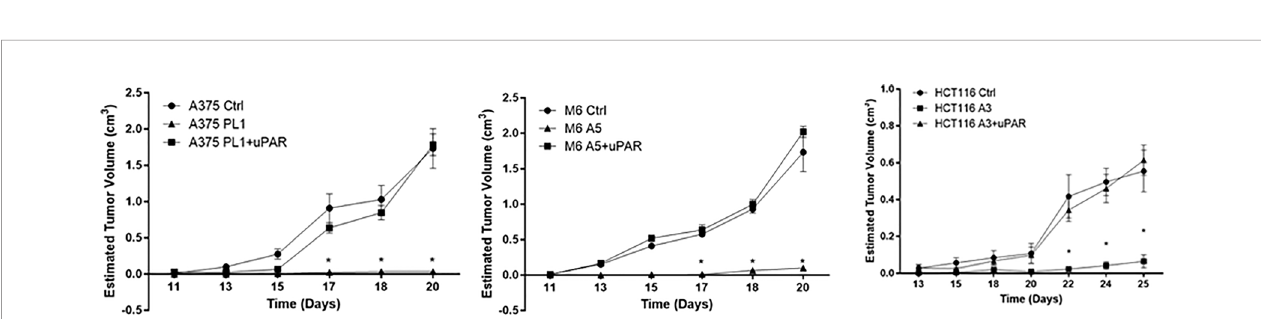
FIGURE 2 | Tumor growth curves of A375 (left), M6 (center) and HCT116 (right); from tumors appearance, masses were measured every two days with a caliper. Each point represents the mean tumor volume (± SD) of measurements from two tumors for every single mouse (n = 5). *p <0.001 (One-Way